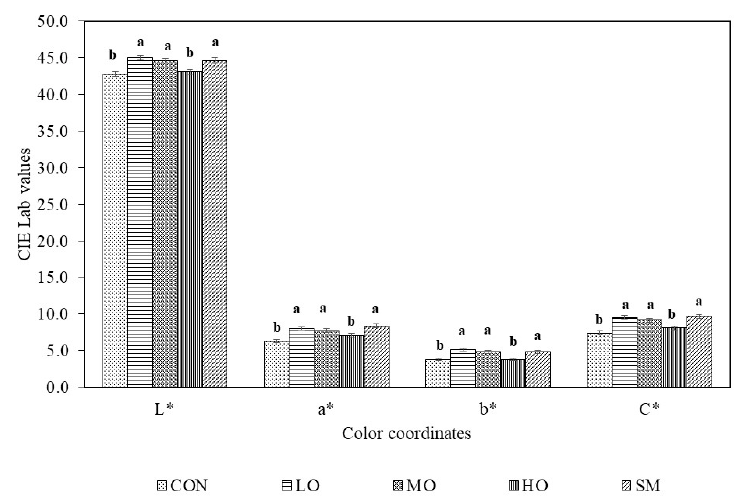
Figure 4. Means ( ± S.E.) of colour coordinates (L*, lightness; a*, redness; b*, yellowness; C*, saturation) in m. Longissimus lumborum of male lambs unsupplemented (CON) or supplemented with three di ff erent levels of oregano essential oils (LO = 0.2 g / kg of DM; MO = 0.3 g / kg of DM; or HO = 0.4 g / kg of DM) or monensin (SM), with 7 d of simulated retail display in modified atmosphere packaging (O 2 :CO 2 , 75:25%). a,b Di ff erent superscripts mean significant di ff erence ( p < 0.05) among treatments.